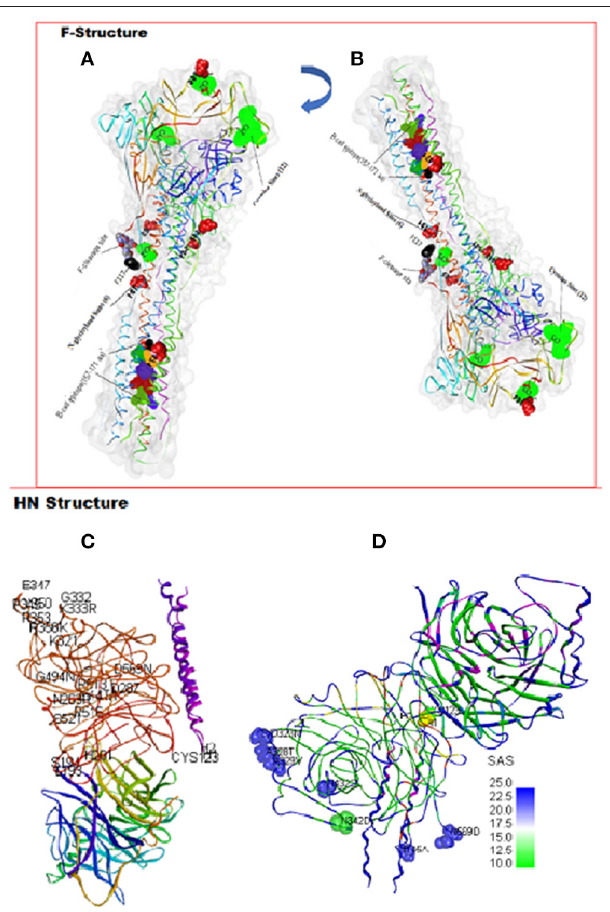
FIGURE 2 | Amino acid substitutions in the predicted F and HN proteins. A PDB-3maw model for predicting variations on LaSota vaccine strain on chain A represented by a ribbon. The N -glycosylation, cysteine, cleavage site, and variable B-cell epitopes are labeled. The structures (A) and (B) are different orientations of the same F protein molecule rotated as shown. A PDB-3T1E chain A model HN protein ectodomain. (C) One dimer of the HN neuraminidase (NA) domain flanks the 2HB in the stalk side-on view packing, conserved amino acids, and substitutions positions at the antigenic sites on the A-chain are indicated. (D) Side-on view packing of HN dimer rotated showing the Cys-123 (yellow), Helices 1 and 2 (H 1 and H 2 ), and eight substituted amino acids (blue/green) in the antigenic sites of the A-chain displayed by solvent accessibility surface (SAS).